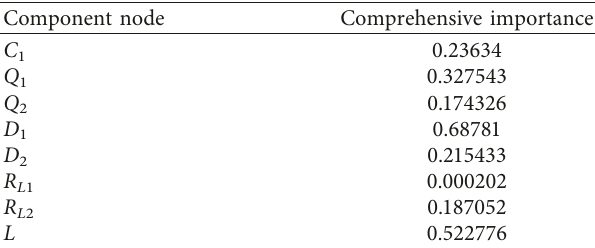
Table 1: Comprehensive importance of each component of the main power conversion circuit.